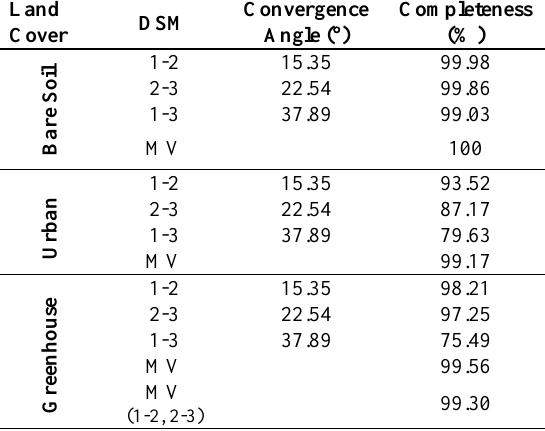
Table 2. Completeness values of DSMs derived from stereo pairs and triplet (MultiView, MV) for each land cover